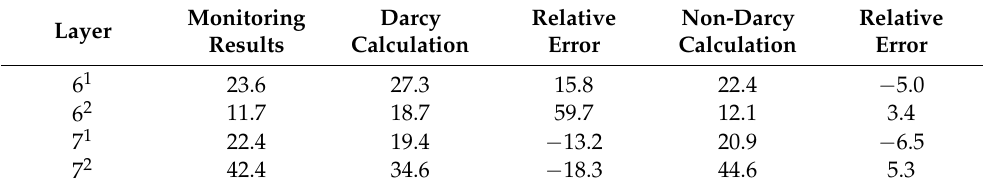
Table 3. Comparison of relative water absorption in Well Y4-4-17 (May 2020).